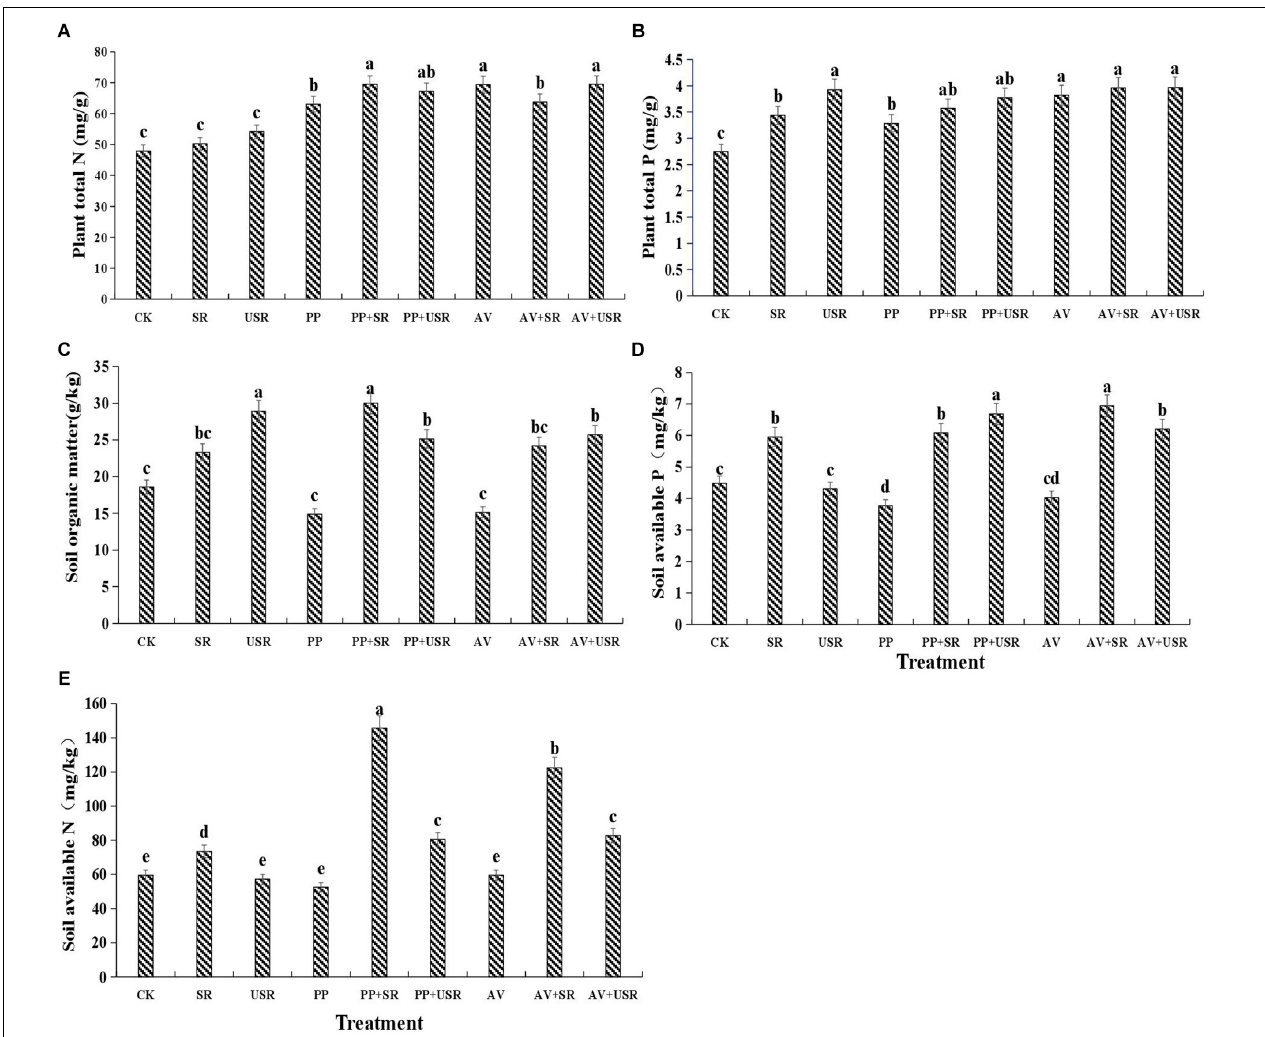
FIGURE 5 | Effects of dark septate endophyte (DSE) inoculation and residues treatment on the plant and soil mineral nutrient contents of liquorice plants. The error bars represent the standard error (SE). Different letters above the error bars indicate significant difference at P < 0.05 by Duncan’s multiple-range tests. CK indicates non-inoculated plants and no liquorice residues. SR, sterilized residue. USR, unsterilized residue. AV, A. vagum . PP, P. putaminum . AV + SR, A. vagum + sterilized residue. AV + USR, A. vagum + unsterilized residue. PP + SR, P. putaminum + sterilized residue. PP + USR, P. putaminum + unsterilized residue. Plant total N of liquorice plants (A) , plant total P of liquorice plants (B) , soil organic matter of rhizosphere soil (C) , soil available P of rhizosphere soil (D) , soil available N of rhizosphere soil (E)